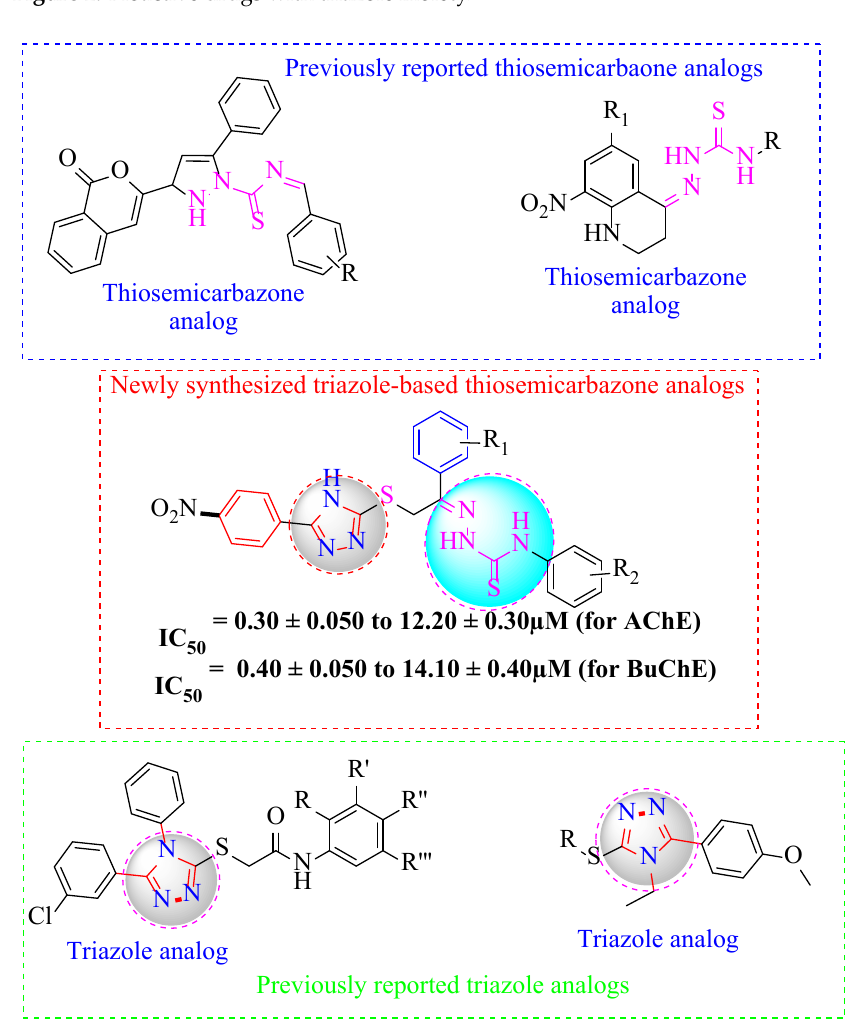
Figure 3. Rationale of the current study.